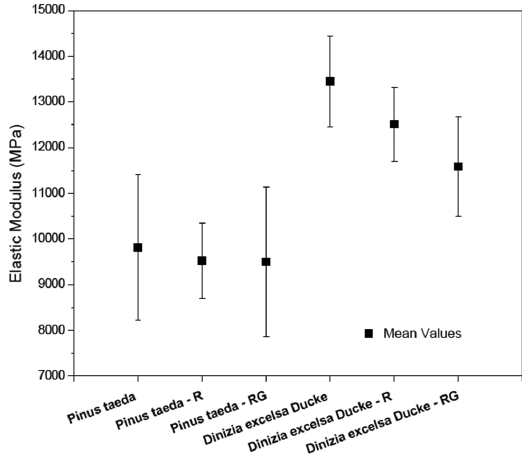
Figure 6. Elastic modulus from samples: in natural state, coated with resin (R) and coated with resin and geotextile fiber (RG).